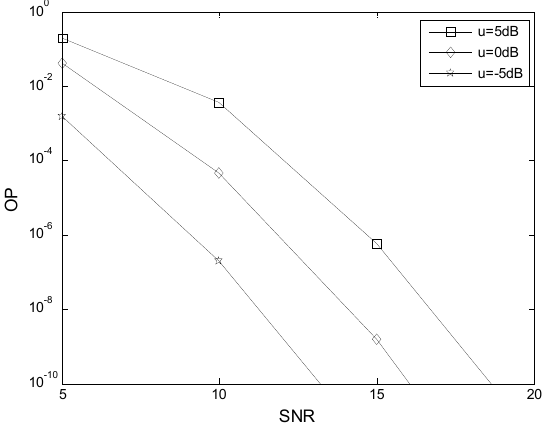
Figure 3. The effect of the relative geometrical gain μ on the OP performance.